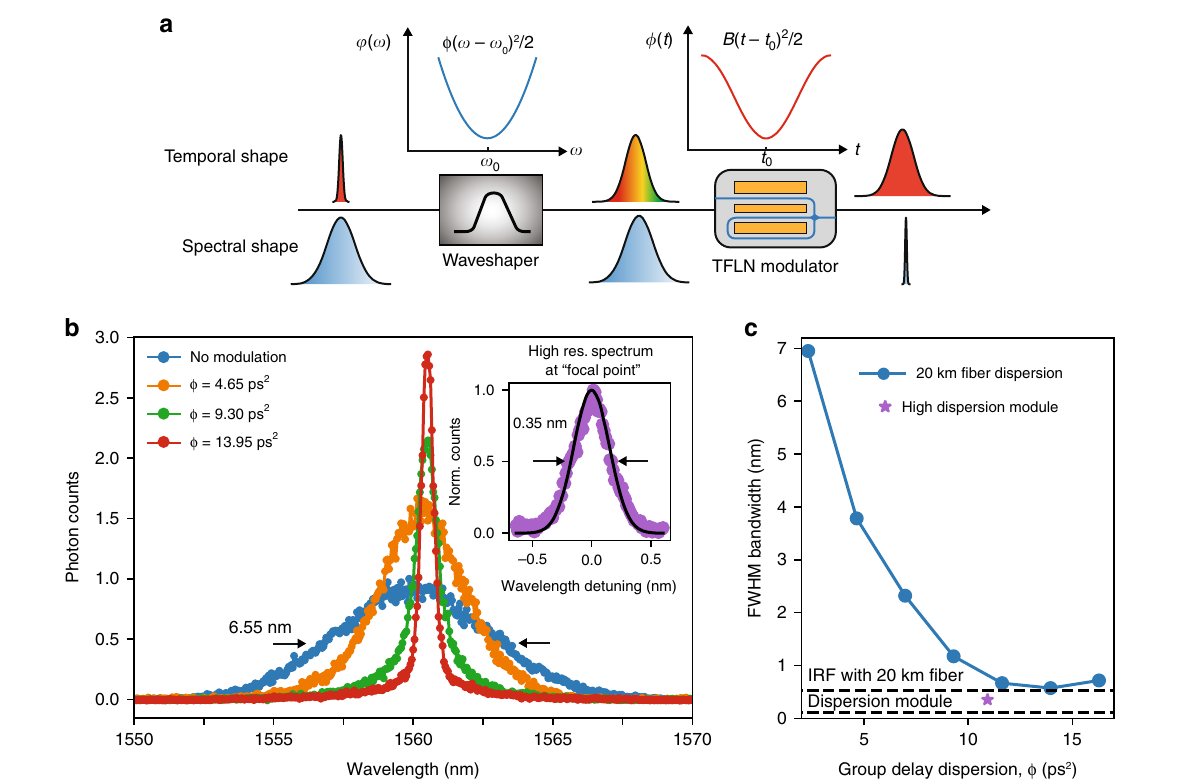
Fig. 5 Bandwidth compression of single photons. a Experimental implementation and illustration of the temporal and spectral evolution of the photon. A waveshaper fi rst applies a quadratic spectral phase (or group delay dispersion, GDD) to the input photon, which stretches the wavepacket in time. The TFLN modulator then adds a quasi-quadratic temporal phase to the photon by synchronizing the photon arrival time to the valley of the sinusoidal phase modulation. This modulation acts as a time lens and compresses the photon bandwidth. b Measured single-photon spectra with different GDDs. At the “ focal point ” ( Φ ¼ 1 = B ), the 6.55 nm FWHM input photon (blue curve) was compressed to 0.35 nm (inset; black solid line: Gaussian fi tting), corresponding to a compression factor of 18.7. c Extracted FWHM bandwidths (from Gaussian fi tting) of the output photons with different GDDs. Spectra in the main panel of ( b ) and blue circles in ( c ) were measured using 20 km fi ber, which has an instrument response function (IRF)-limited resolution of 0.53 nm; inset of ( b ) and purple star in ( c ) were measured using a high dispersion module made of a chirped fi ber Bragg grating, which has an IRF-limited resolution of 0.11 nm. The TFLN modulator was driven at 13.6 GHz and 4.0 V